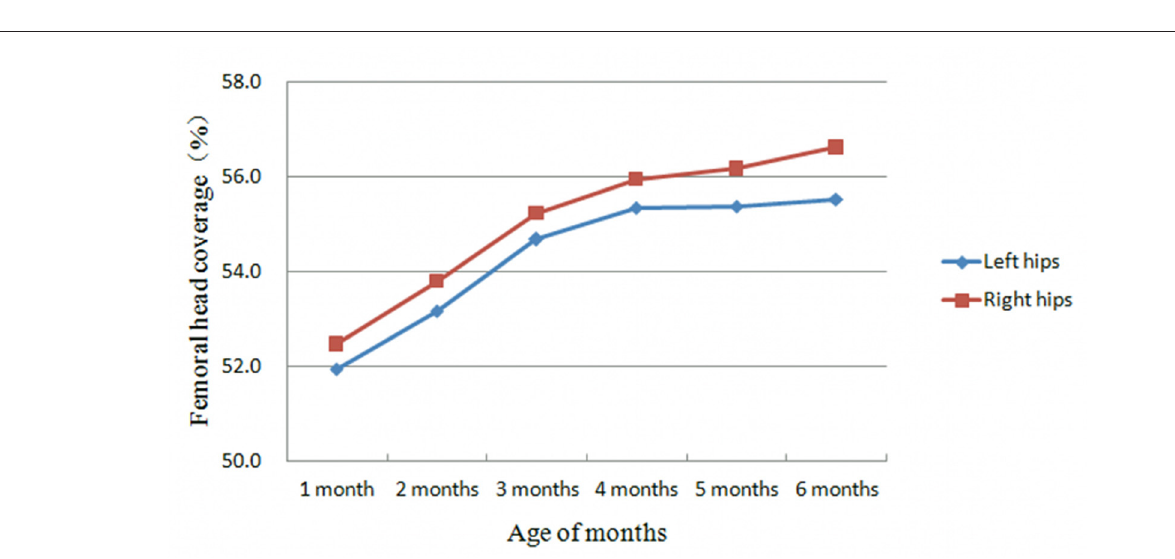
FIGURE 3 | Development trend of femoral head coverage with age of